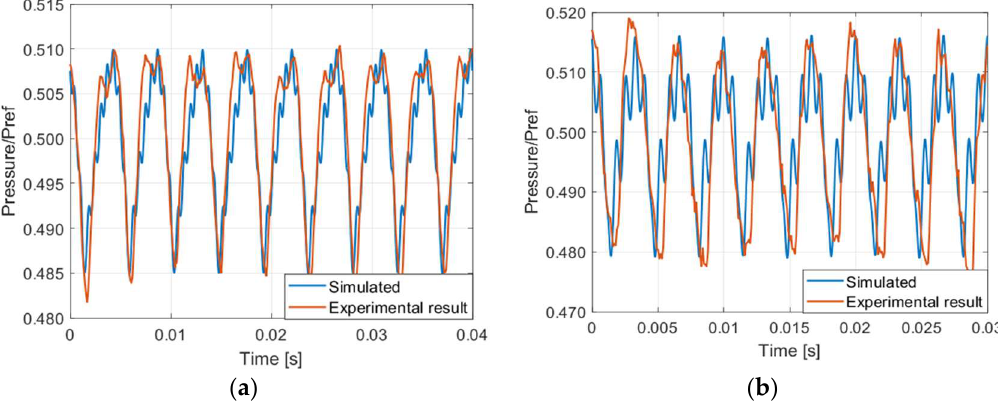
Figure 8. ( a ) Delivery pressure at 1500 r/min, swash plate position 12.7°; ( b ) Delivery pressure at 2000 r/min, swash plate position 12.8°. The mean pressure of case ( b ) is higher than the one of case ( a ).